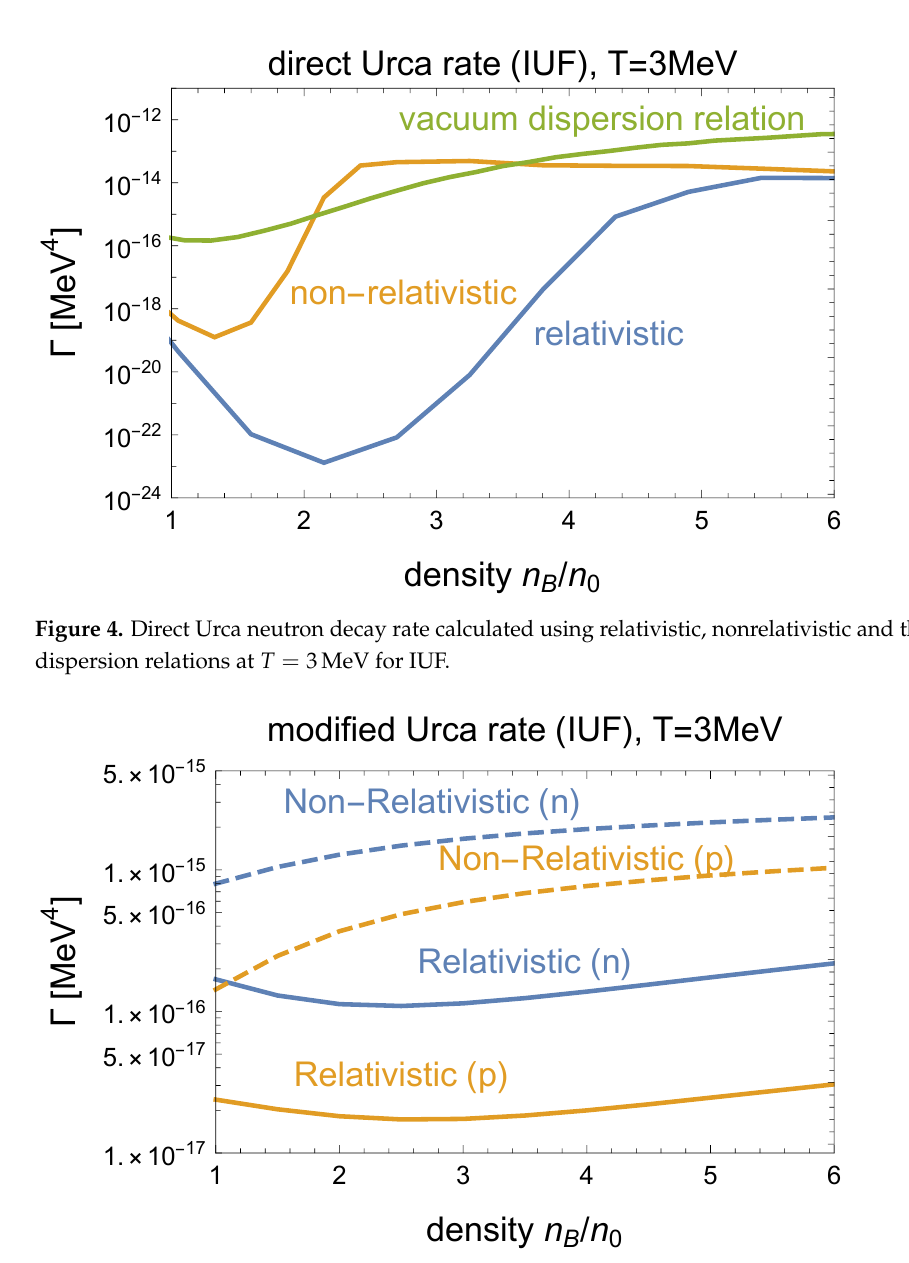
Figure 5. Modified Urca rate calculated using relativistic and nonrelativistic dispersion relations at T = 3MeV for IUF. (n) stands for neutron-spectator modified Urca and (p) stands for proton-spectator modified